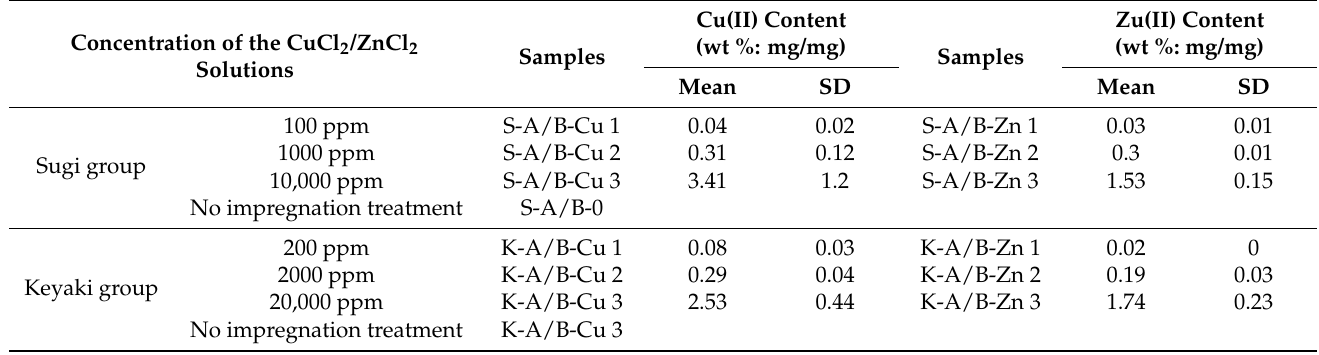
Table 1. The metal ion contents in the wood plate samples after